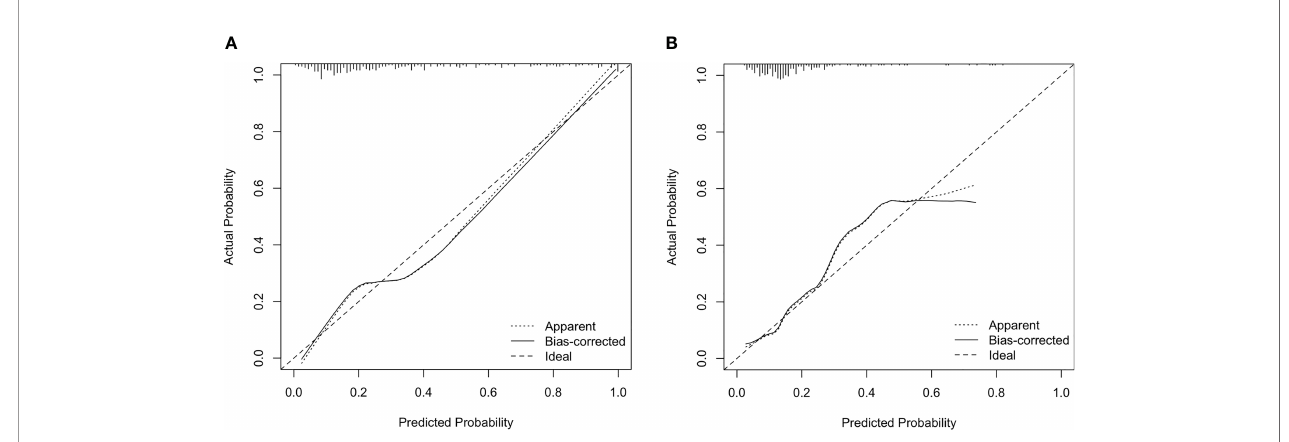
FIGURE 7 | Calibration plot for internal validation of the Luminal subtypes (A) and triple-negative subtype (B) . The x-axis is the nomogram-predicted probability of genotypes. The y-axis is the actual probability. The dotted line represents an ideal standard curve; the solid line represents the prediction calibration curve of the nomogram. The solid line has a closer fi t to the ideal dotted line, which indicates better predictive accuracy of the nomogram (p = 0.22,